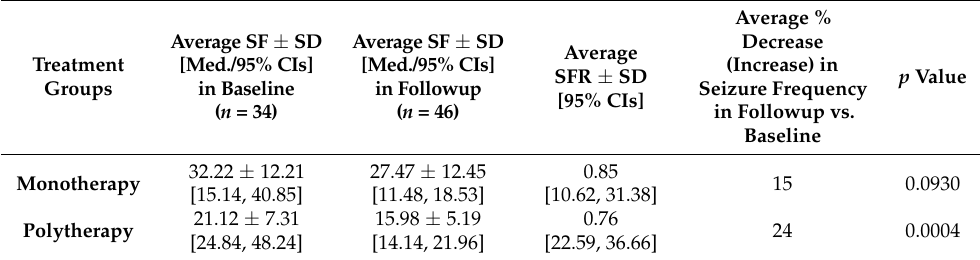
Table 4. Comparative analysis of the pharmacotherapy regimen efficacy among pediatric patients with